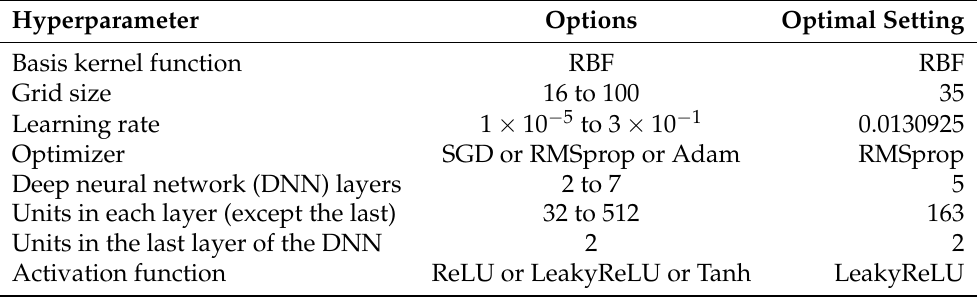
Table 1. Hyperparameters for the deep kernel model used in our